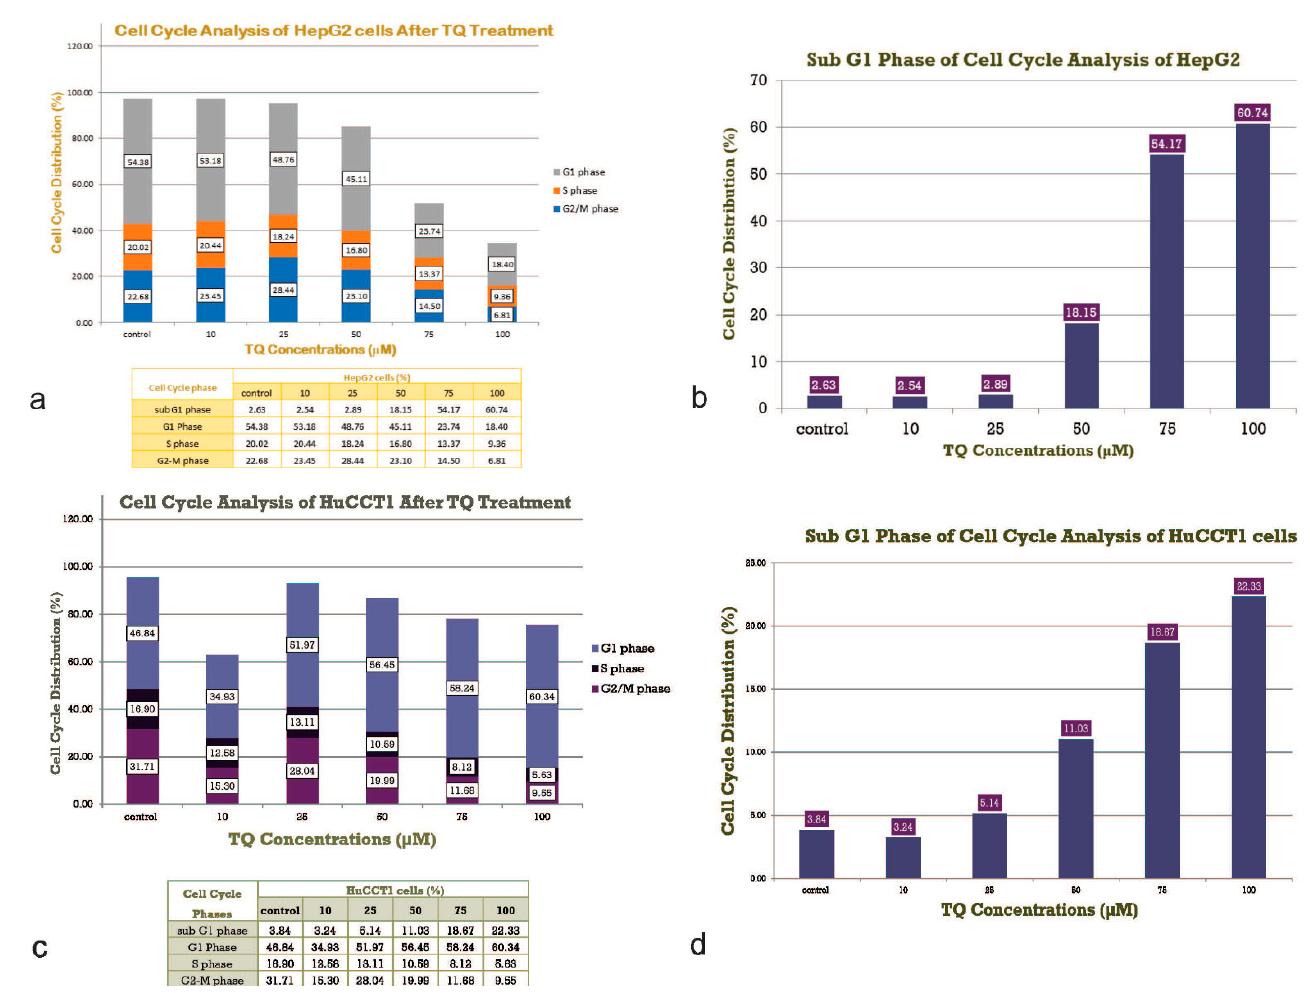
Figure 3. ( a ) Cell cycle Analysis of HepG2 cells after TQ Treatment. ( b ) Histogram of the Cell Cycle with the Sub G1 Phase of the Cell Cycle of the HepG2 cell lines. ( c ) Cell cycle Analysis of HuCCT1 cells after TQ Treatment. ( d ) Histogram of the Cell Cycle with the Sub G1 Phase of the Cell Cycle of the HuCCT1 cell lines. In ( a , b ), a histogram of the Cell Cycle distribution of the HepG2 cell lines is shown. The results shown are one representative of three individual experiments. In ( c , d ), the distribution of the cell cycle phases in the HuCCT1 cell lines is shown. Values are presented as the mean of 3 individual experiments ± SEM. Table 2. Cell Cycle Distribution of Cell Lines following Exposure to TQ treatments. Results shown are one representative of three independent